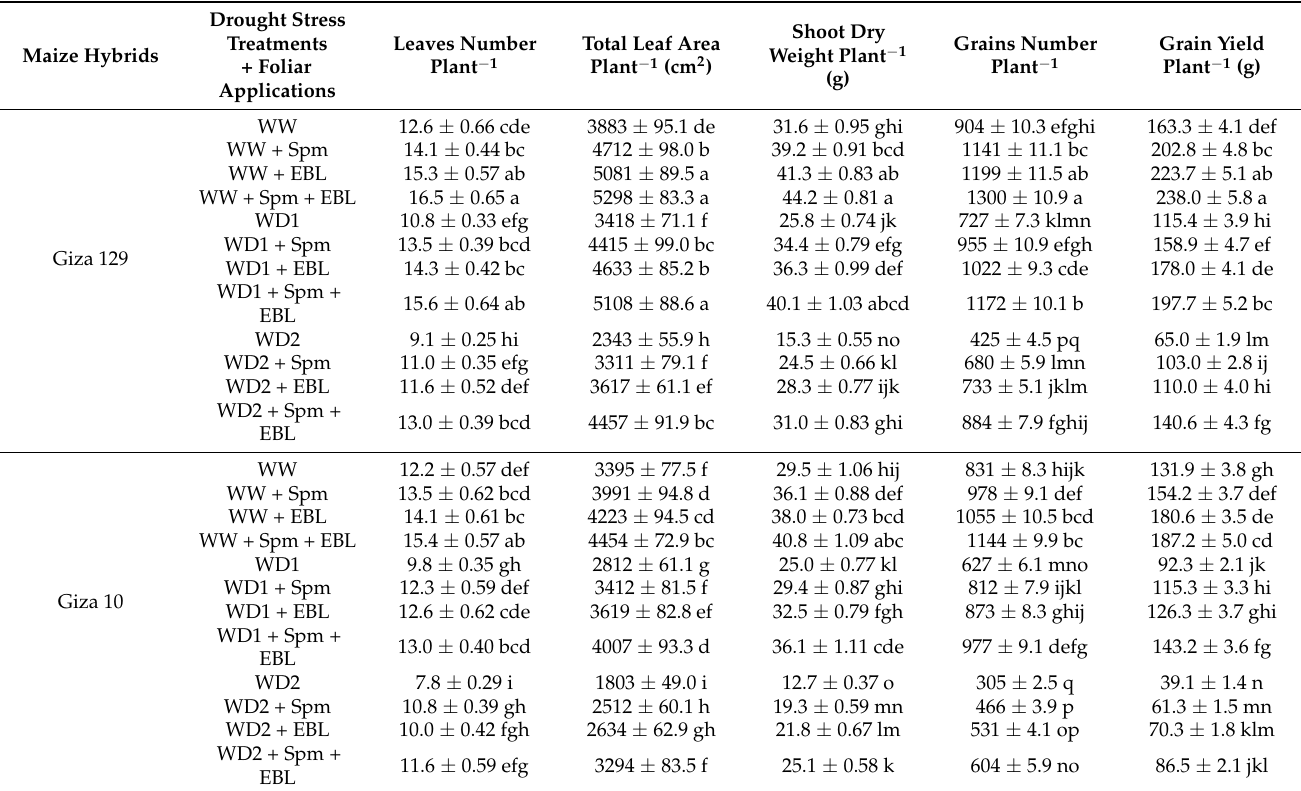
Table 3. Variations in leaf number, total leaf area, shoot dry weight, grains number, and grain yield of two maize genotypes—Giza 129 and Giza 10—grown under different drought stress treatments (control (100% field capacity (FC); WW) and water deficit (75% FC and 50% FC; WD1 and WD2)) and exposure to foliar applications of distilled water (control), 25 mg L − 1 Spm, 0.1 mg L − 1 EBL,